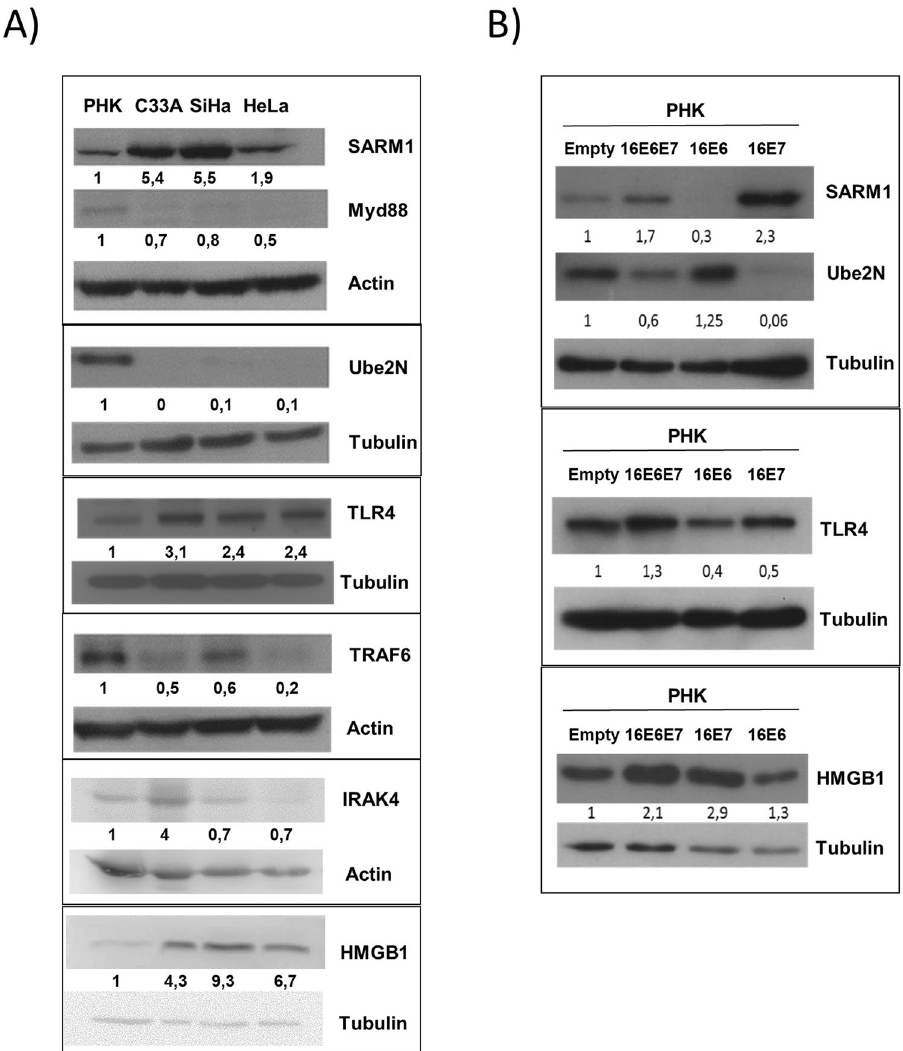
Figure 2. Cervical cancer cell lines and PHK expressing HPV16 oncogenes exhibit alterations in the expression of TLRs related proteins. ( A ) Tumor-derived cell lines C33A, SiHa, and HeLa, ( B ) PHK expressing HPV16 oncogenes E6 and/or E7. Protein levels were determined by Western blot analysis from cell culture extracts. Signals obtained were quantified using ImageJ software and are reported as expression relative to normal keratinocytes (PHK). Full-length blots are presented in a Supplementary